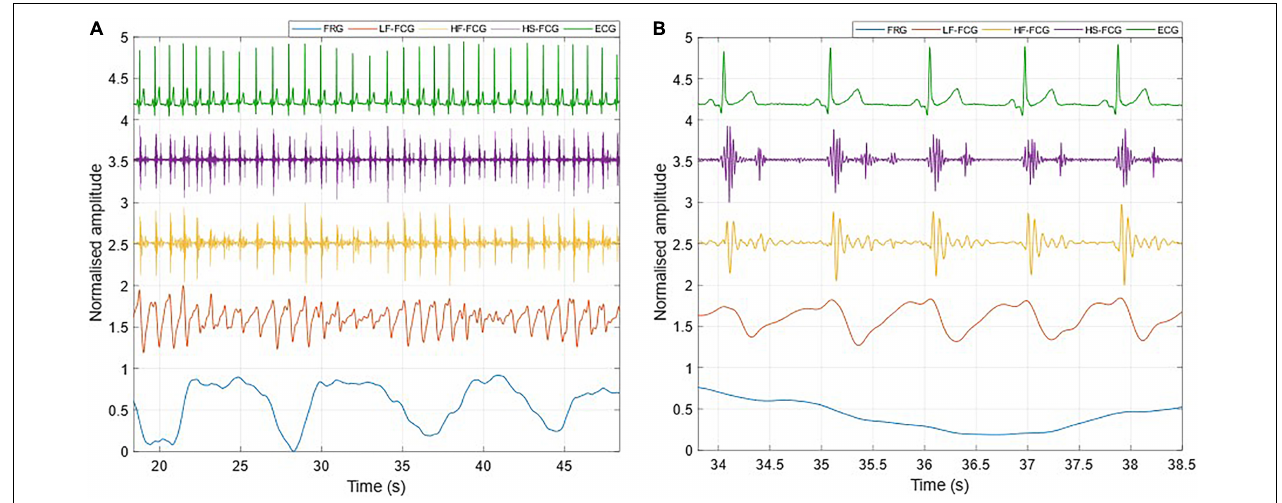
FIGURE 4 | All components extracted from the FCG signal acquired by the PZT sensor. (A) 30-s excerpt from subject #2; (B) 5-beats excerpt at the beginning of (A) .